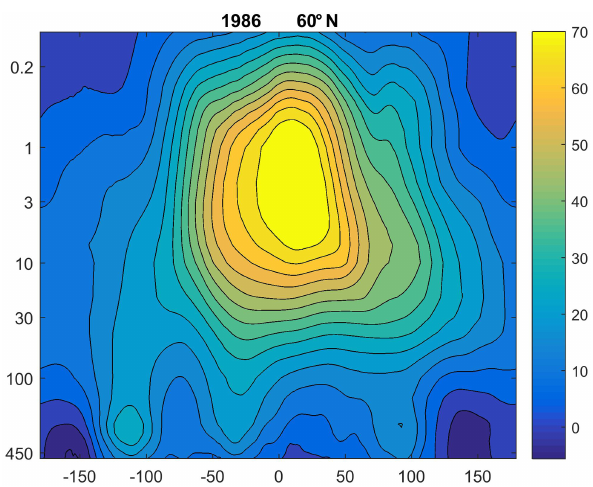
Figure 7. Monthly mean zonal wind in “ordinary” January 1986. Strong stratospheric winds in the Euro-Atlantic sector and weak winds in the Aleutian sector are clearly